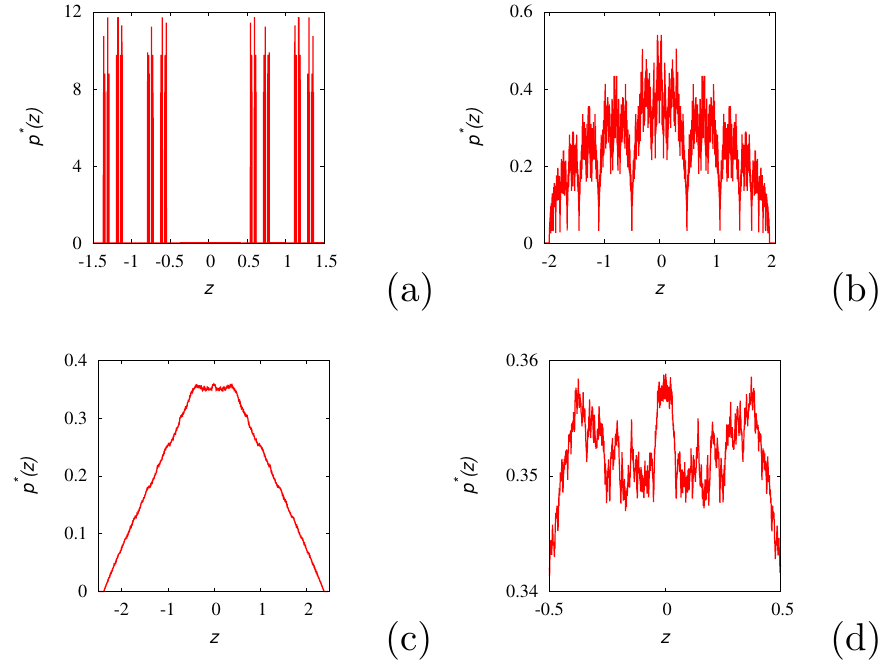
Figure 5. p ∗ ( z ) vs. z obtained from Monte Carlo simulations of the IFS Equation (31) at different values of α . Panel ( a ) refers to α = 0.3, panel ( b ) to α = 0.6, panel ( c ) to α = 0.7, panel ( d ) to a zoom-in of the density at α = 0.7, depicted in panel ( c ) close to z =